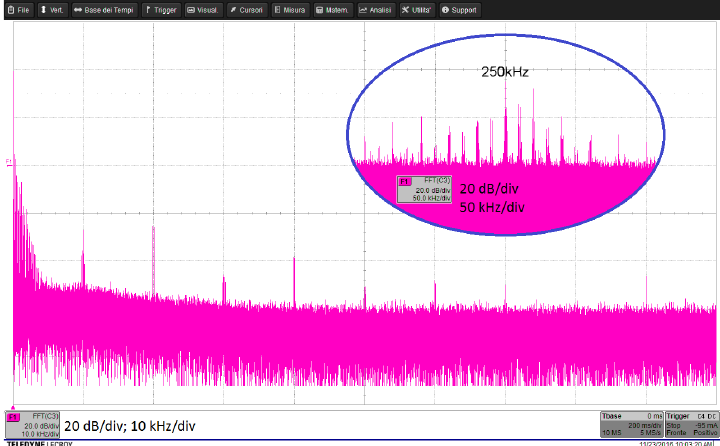
Figure 12. Spectral analysis of the voltage output of H6 converter. Frequency range of 0–100 kHz in the main figure, 200–300 kHz in the small round box